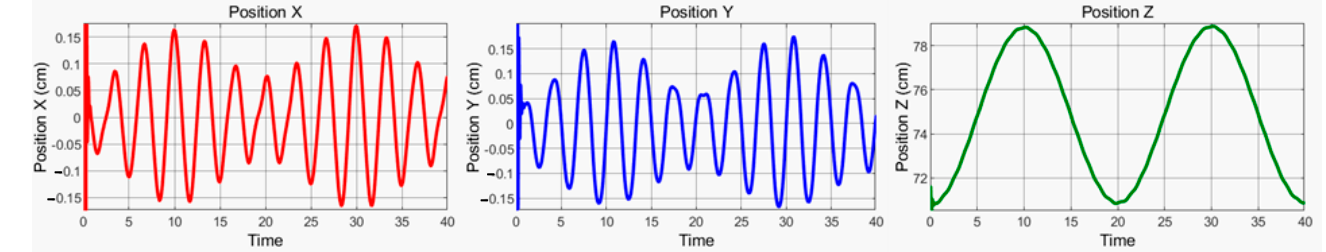
Figure 14. Moving plate position simulation results for a given reference sun trajectory. The designed solar tracker was first simulated in Simulink. Because the photovoltaic panel could not be placed on the Stewart platform in Simulink, the power generation, which is the actual output variable of the system, could not be examined. For this reason, the lengths of the six legs, which are the output variables of the dynamic model, were examined. The desired leg lengths were calculated by the model and are shown in Figure 15. By applying a force input close to the sun’s trajectory to the input of the Simulink model, the lengths of the legs were measured from the output and are shown in Figure 16. The measured lengths were compared with the lengths desired by the model and the differences between them in cm are shown in Figure 17. As can be seen from this graph, the amount of error did not exceed ± 0.2 cm.